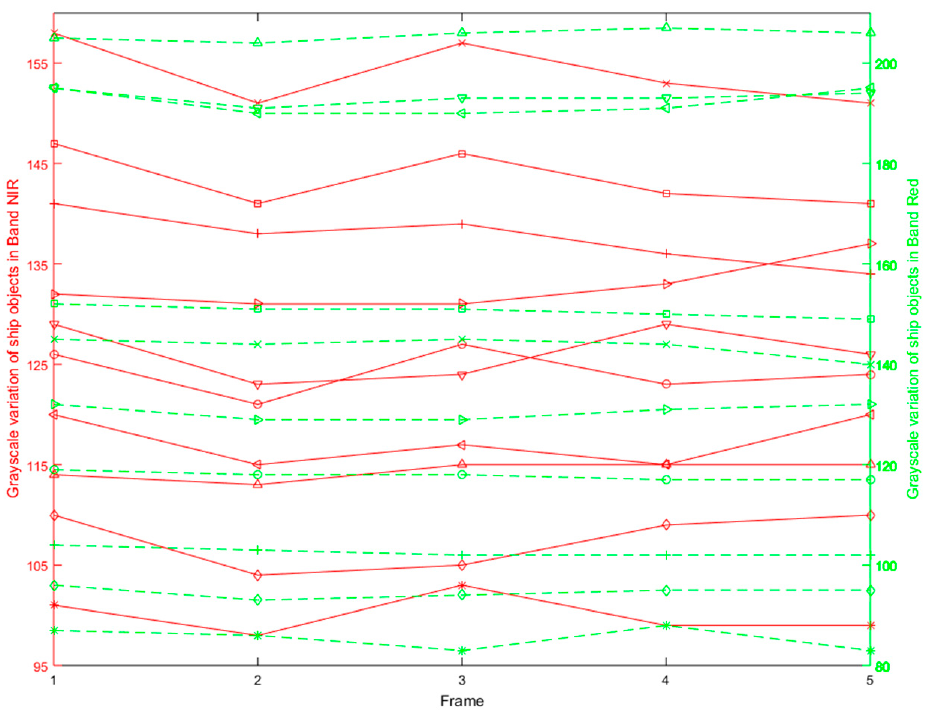
Figure 10. Multispectral grayscale variations of 10 ships over multiple frames. Different marks denote different ships.